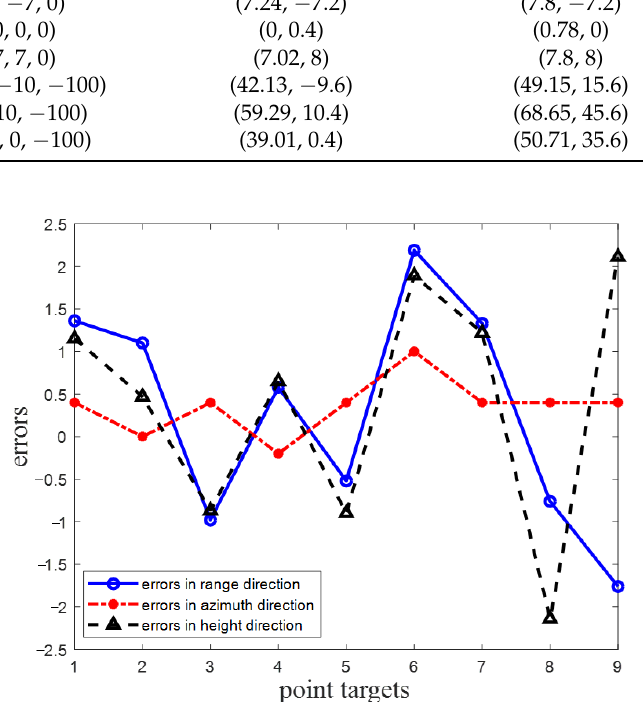
Figure 11. Extraction errors of nine point targets.